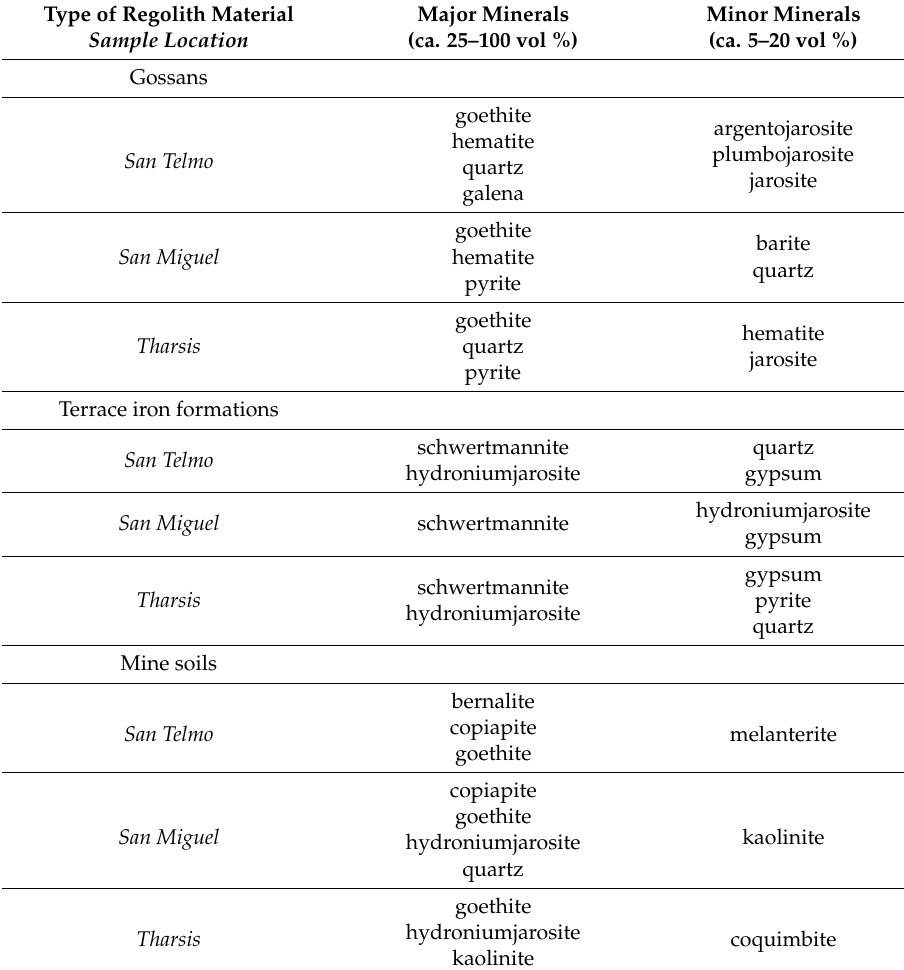
Table 1. Identification and semi-quantitative abundances of minerals comprising gossan, terrace iron formations and mine soils based on XRD analysis.